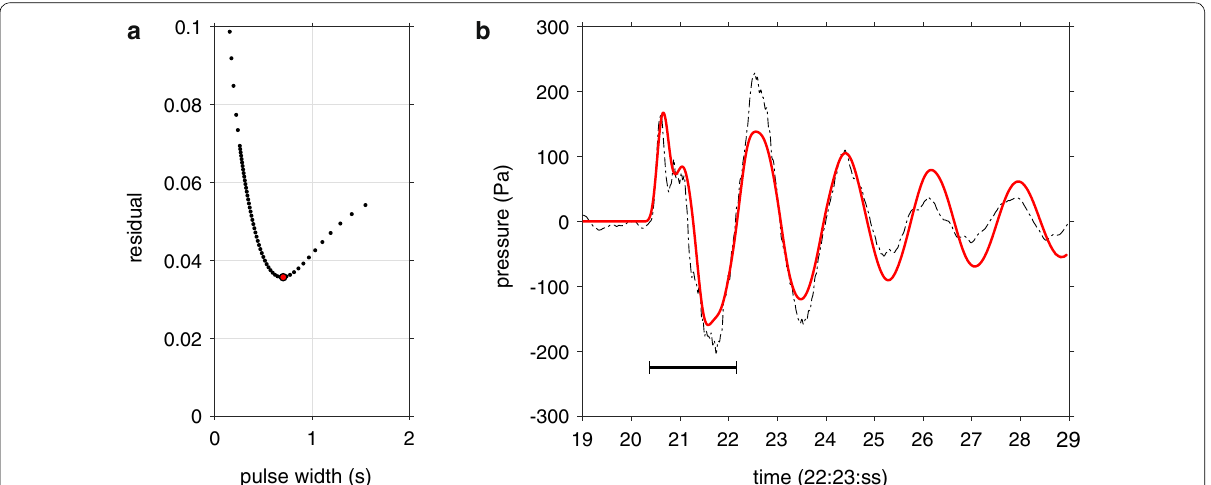
Fig. 10 Comparison of synthetic and observed infrasound waveforms. a Residual between synthetic and observed infrasound waveforms (only for the first one cycle as indicated by a horizontal bar in b ; at 22:23:20 on March 25, 2015). The minimum value (red point) is marked on the simulated waveform using a 0.70-s width pulse inside a 118-m-long conduit. b Waveform fits between synthetic and observed infrasound waveforms (red solid and black broken lines,